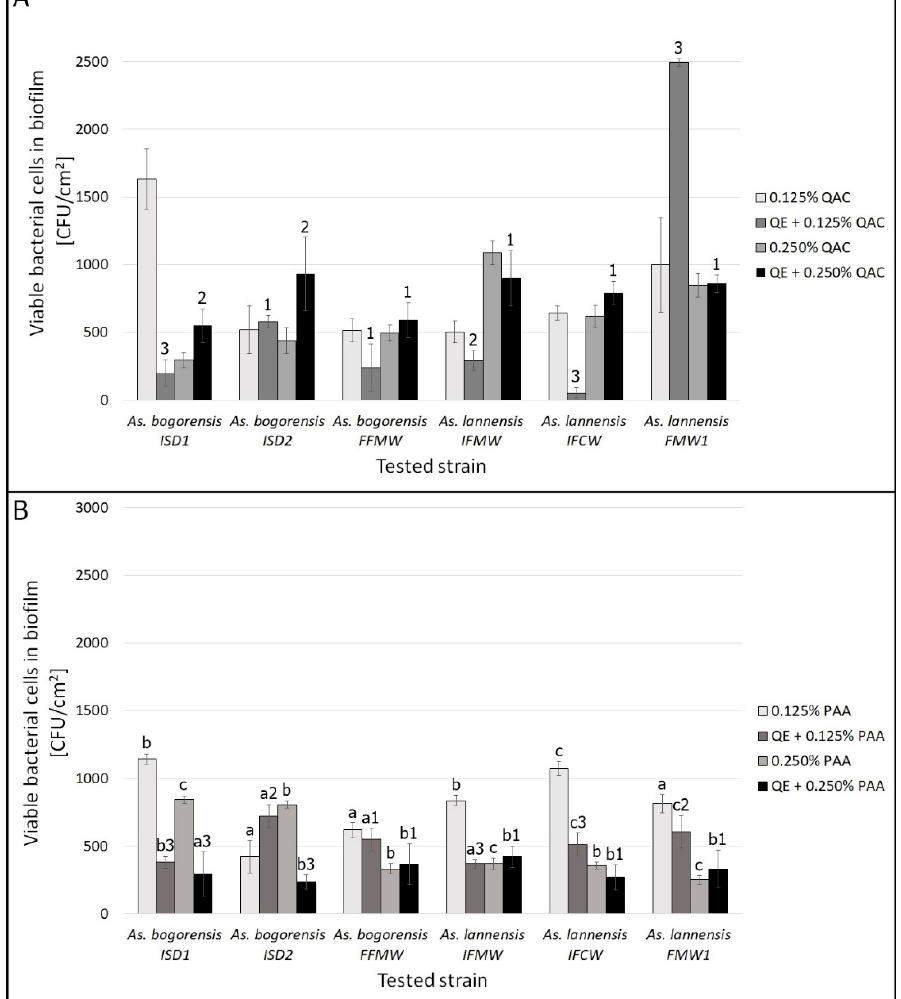
Figure 2. Effect of mature biofilm eradication by disinfectants: ( A ) N ‐ ethyl ‐ N , N ‐ dimethylhexadecylammonium bromide (QAC) and ( B ) peracetic acid (PAA) acting alone or in combination with Q. saponaria extracts (QE). Plate count method (CFU/cm 2 ). Values with the different superscript lowercase signs are statistically different ( p < 0.05). Lowercase letters for PAA results compared to those for QAC: a p > 0.05; b 0.001 < p < 0.05; c p < 0.001. Lowercase numbers for disinfectant results compared to those for QE+ disinfectant: 1 p > 0.05; 2 0.001 < p < 0.05; 3 p < 0.001.